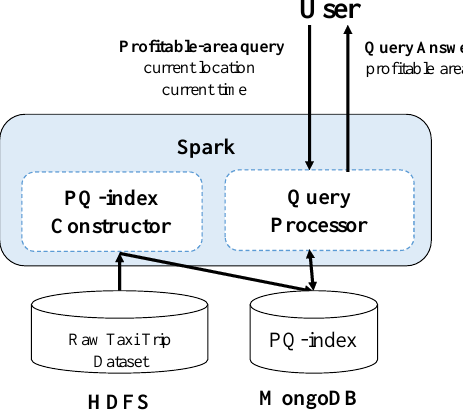
Figure 2. High-level architecture of Distributed Profitable-Area Query ( DISPAQ ).